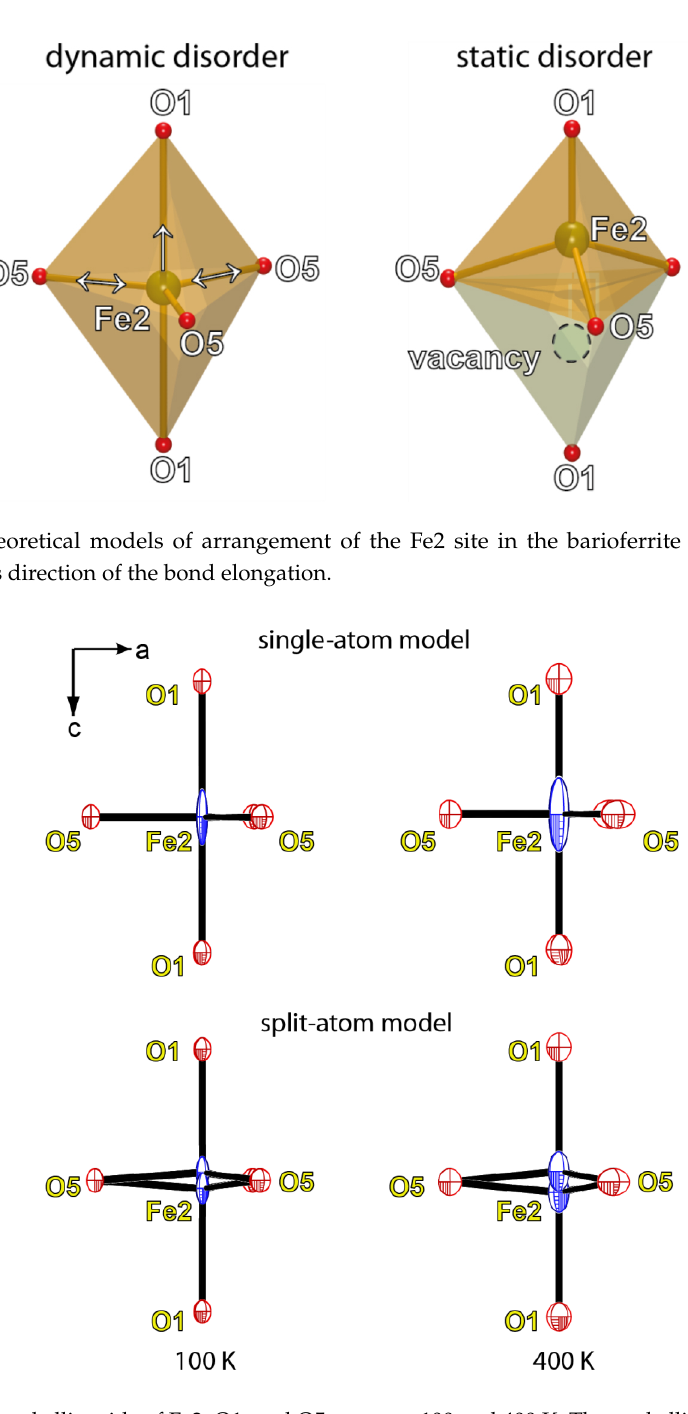
Figure 8. Thermal ellipsoids of Fe2, O1, and O5 atoms at 100 and 400 K. Thermal ellipsoids are drawn at the 90% probability level.